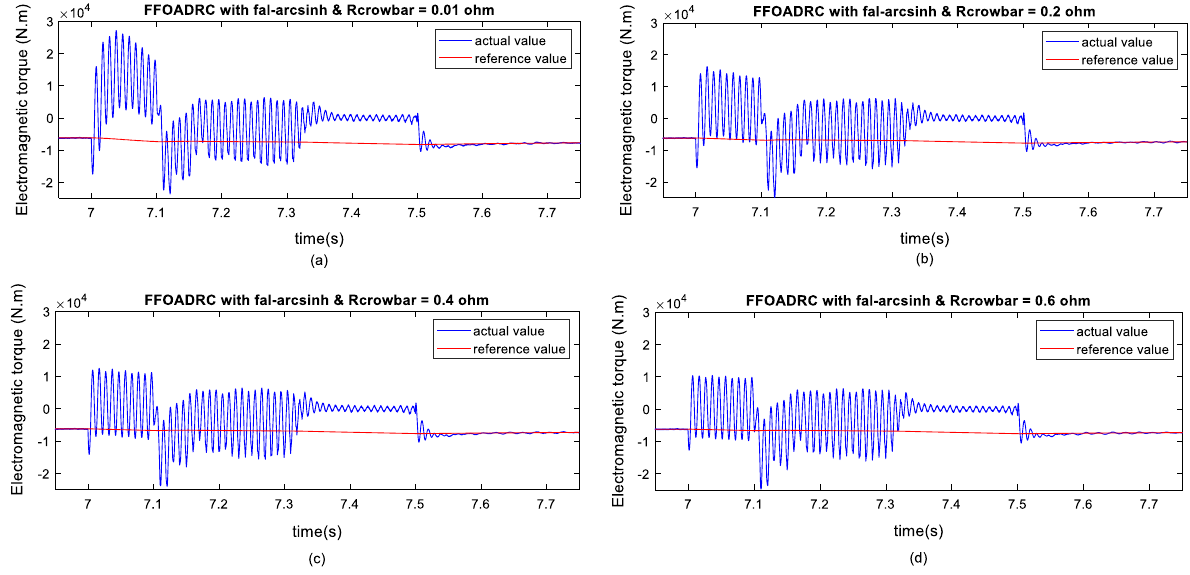
Fig. 35 Electromagnetic torque of the DFIG during asymmetrical voltage sag for different values of R crowbar . ( a ) R crowbar ohm, ( c ) R crowbar 0.4 ohm, and ( d ) R crowbar =